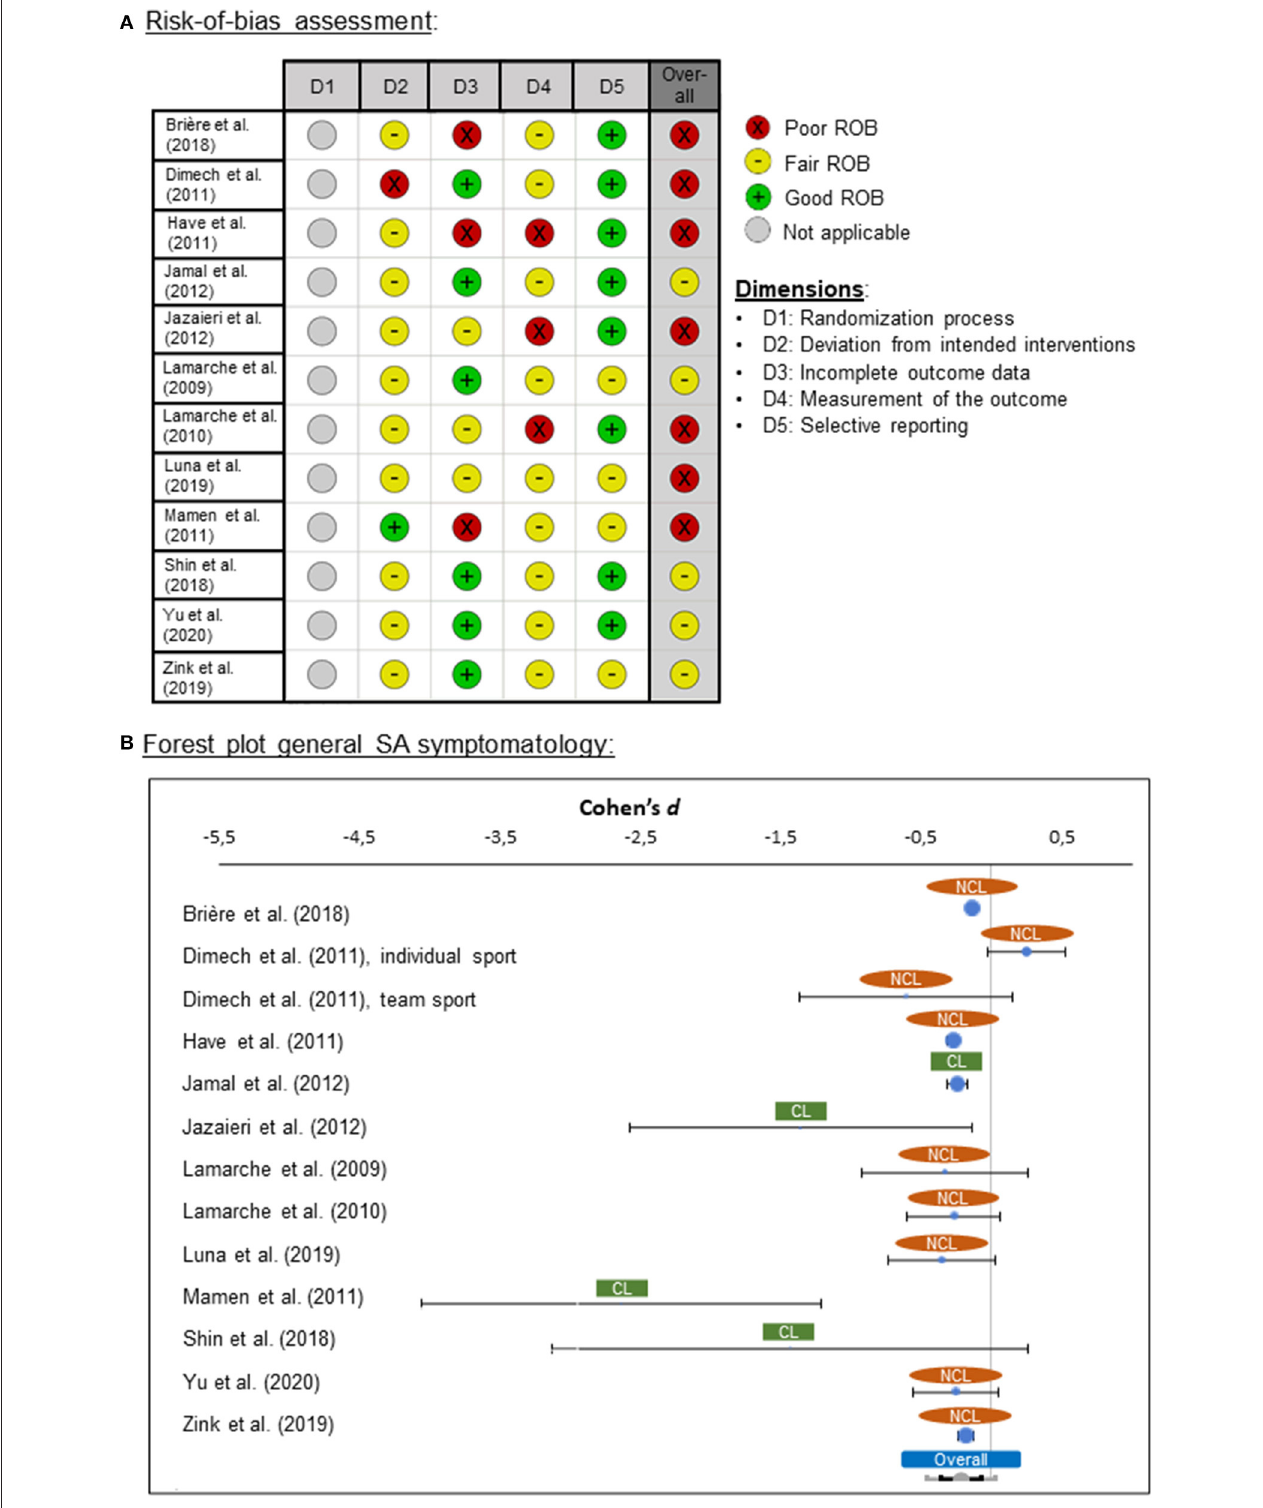
FIGURE 3 | (A) Risk-of-bias (ROB) quality ratings for the longitudinal studies, (B) forest plot for general social anxiety (SA) symptomatology for clinical (CL) and non-clinical (NCL) samples. ROB was assessed by means of the “Quality Assessment Tool for Before-After (Pre-Post) Studies With No Control Group” from the National Heart, Lung, and Blood Institute (2019). Negative effect sizes indicate that symptomatology was lower at the second measurement time point (post-intervention) than at the first time point (pre-intervention).